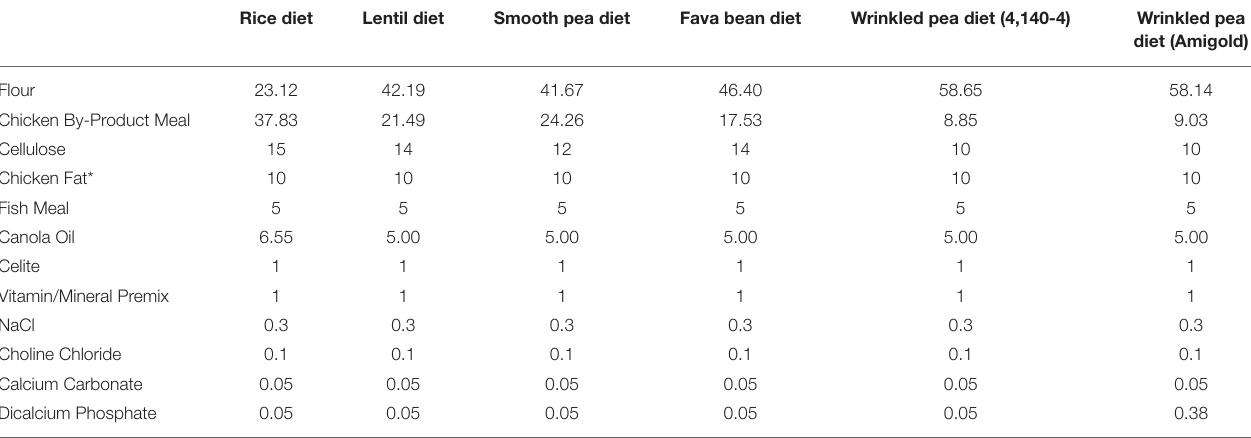
TABLE 1 | Formulation of test diets with increasing fiber and amylose content listed from left to right. All diets were formulated to include 20% available carbohydrate. Rice diet Lentil diet Smooth pea diet